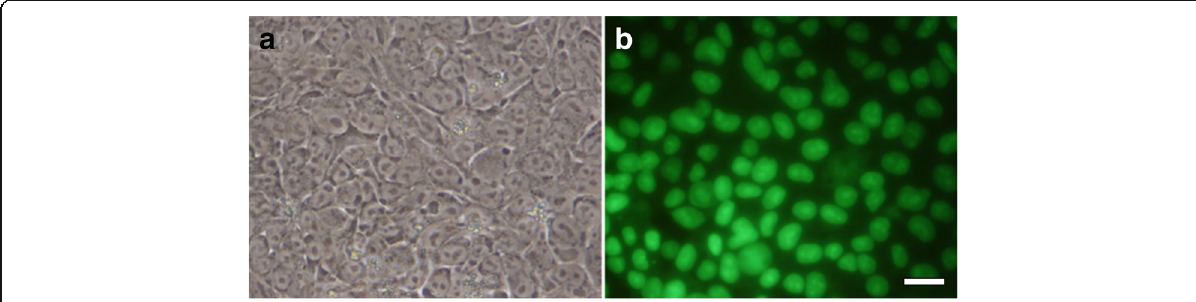
Fig. 2 Photographs of hESC activated by doxycycline to overexpress FGF-2. a Phase-contrast; ( b ) florescence light. Scale bar: 20 μ m